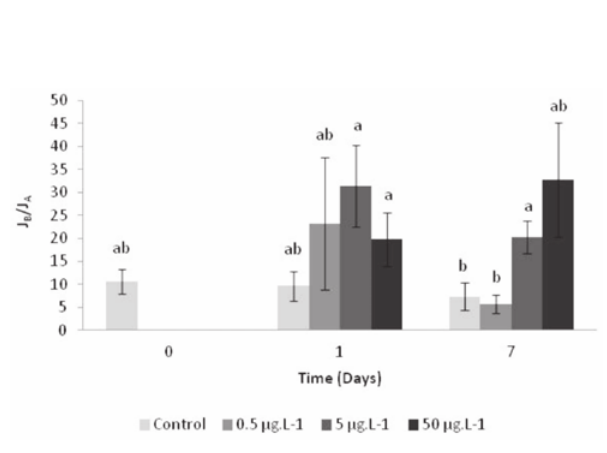
Figure 1. Relative gene expression of hexokinase during etho- fumesate exposure at 10°C in white muscle of roach. Different letters indicate significant differences for a same time (P<0.05). *Corresponds to outliers. Bars with ¤ indicate significant differ- ences for a same concentration.